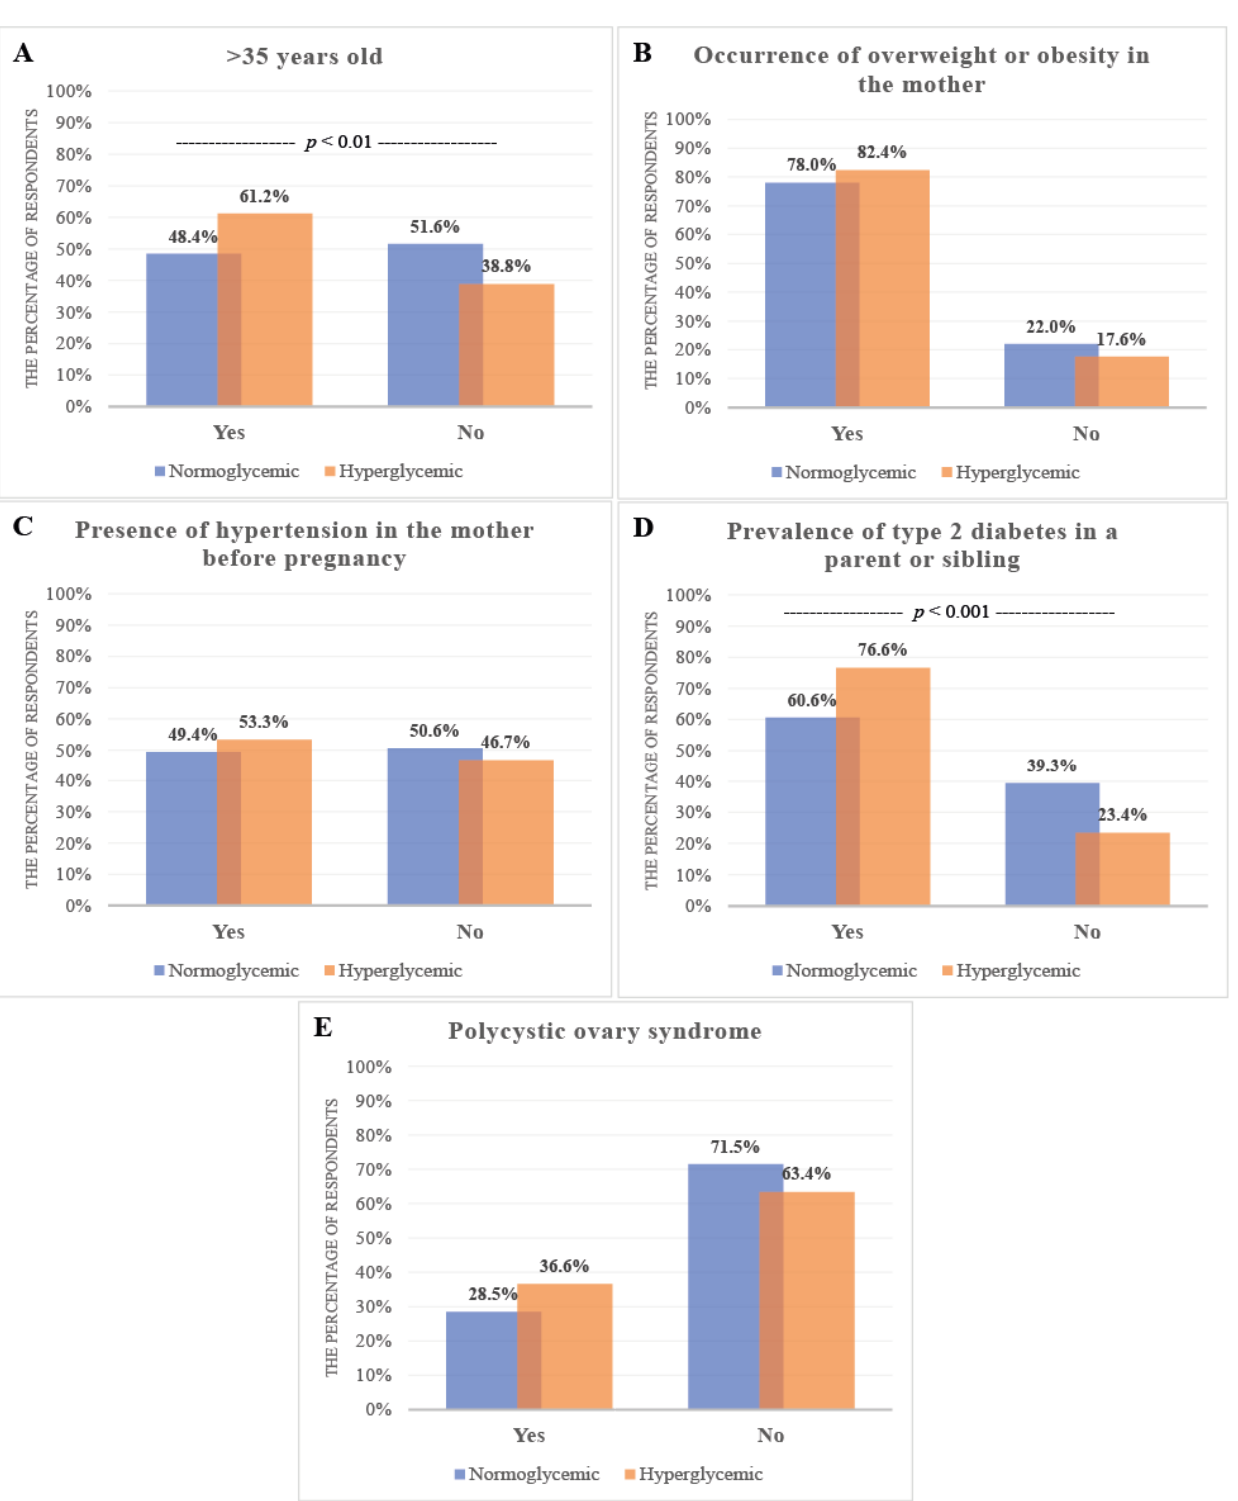
Figure 2. Women’s knowledge concerning the maternal risk factors for GDM in relation to maternal glycemic status. Knowledge levels among hyperglycemic and normoglycemic mothers. ( A ) Age of mother > 35 years old, ( B ) Excess weight or obesity in the mother, ( C ) Presence of hypertension in the mother before pregnancy, ( D ) Prevalence of type 2 diabetes in a parent or sibling, ( E ) Occurrence of polycystic ovary syndrome in the mother. The y axis expresses the percentage of women who said ‘yes’ or ‘no’.